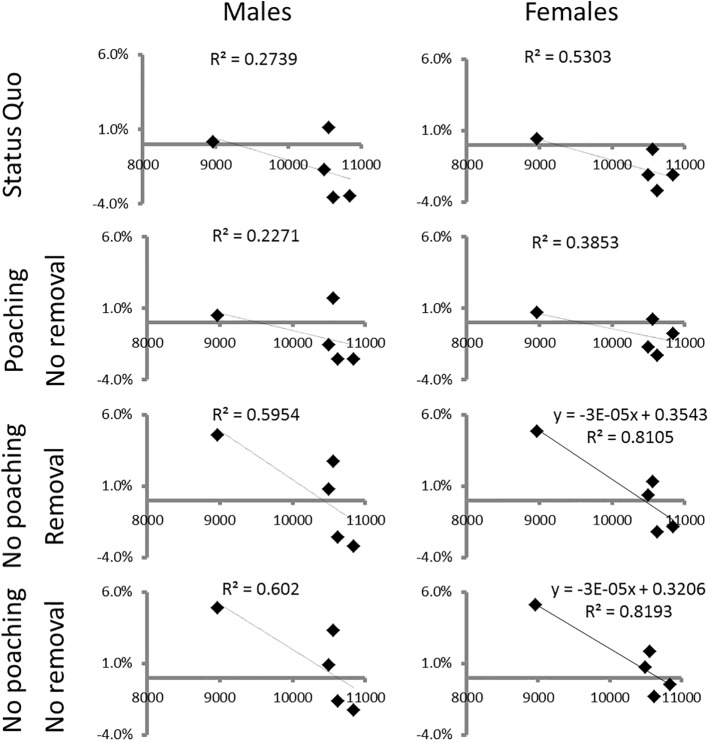
Estimated annual population growth rates as a function of population size.We illustrate how poaching and management removals may influence these relationships. Solid lines are significant relationships.